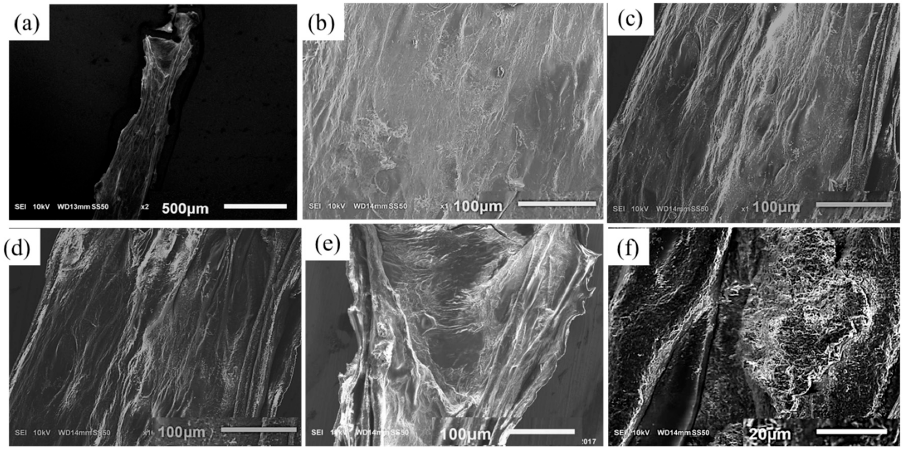
Figure 17. Scanning electron microscopy of filament with ( a , b ) 4% Alg and ( c ) 4% Alg-4% CMC before incubation, ( d – f ) 4% Alg-4% CMC after 3 days of incubation.